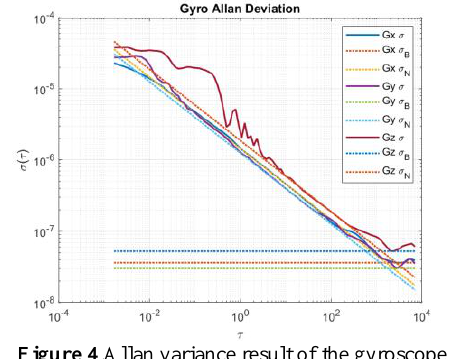
Figure 4 .Allan variance result of the gyroscope